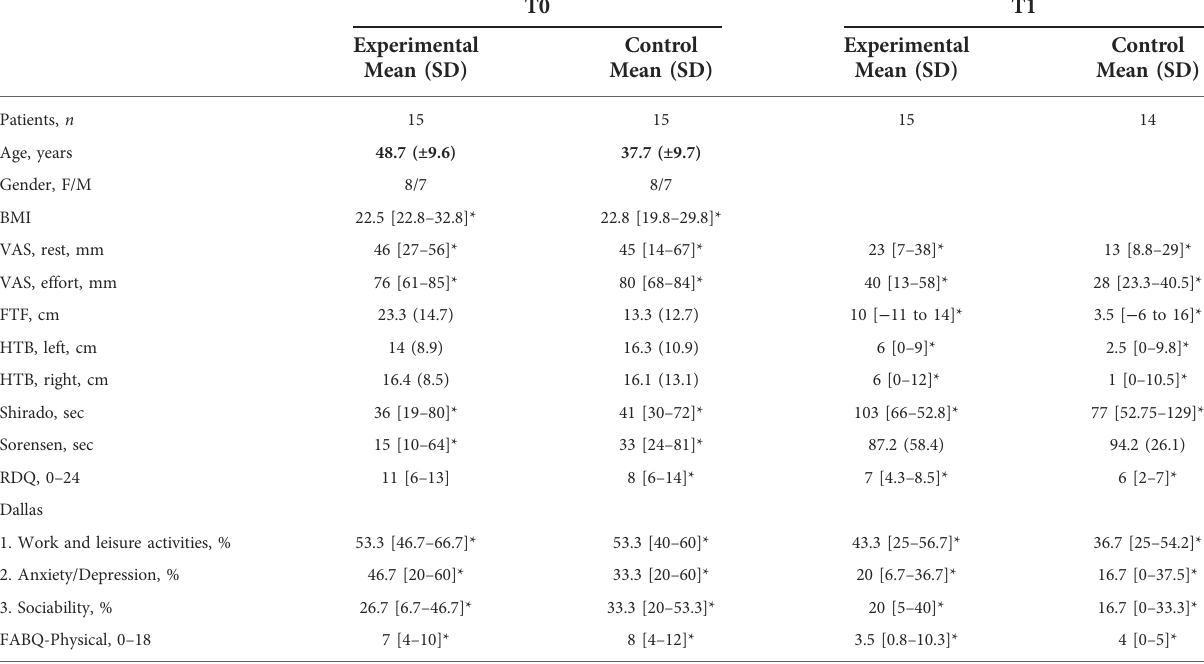
TABLE 2 Group comparison before the multidisciplinary programme (T0) and before the home-based programme (T1). T0